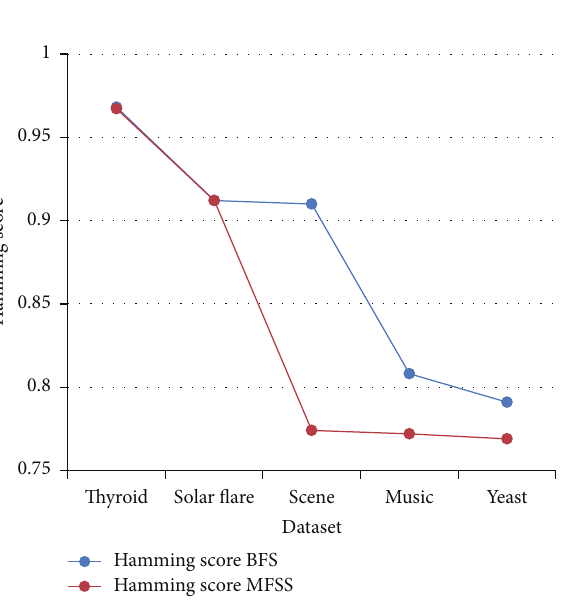
Figure 3: Hamming score-Naive Bayes.